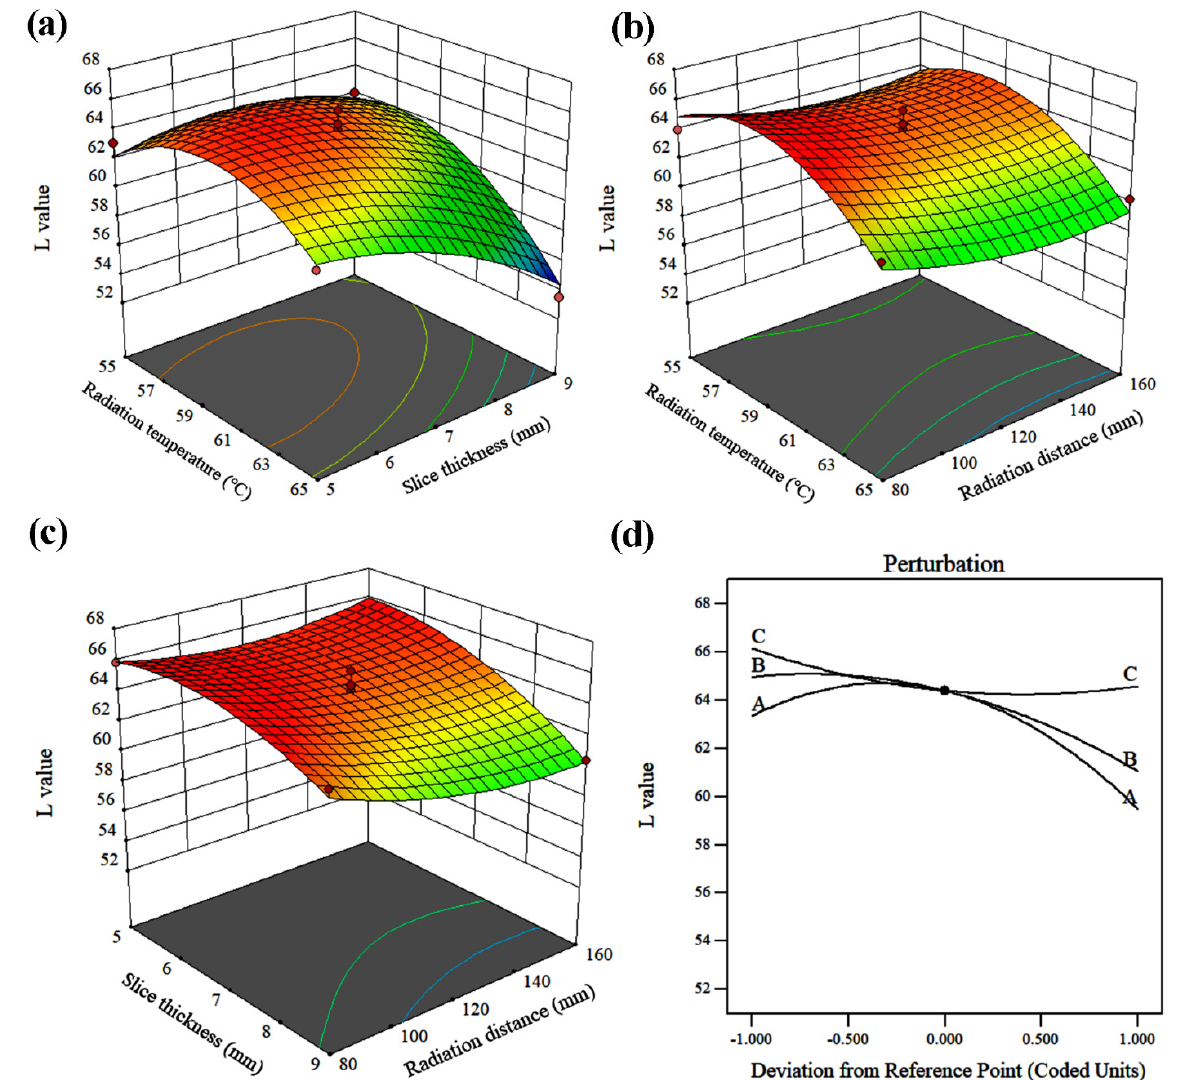
Figure 4. Response surface ( a – c ) and perturbation plot ( d ) for the effects of variables on the L value of cantaloupe slices.